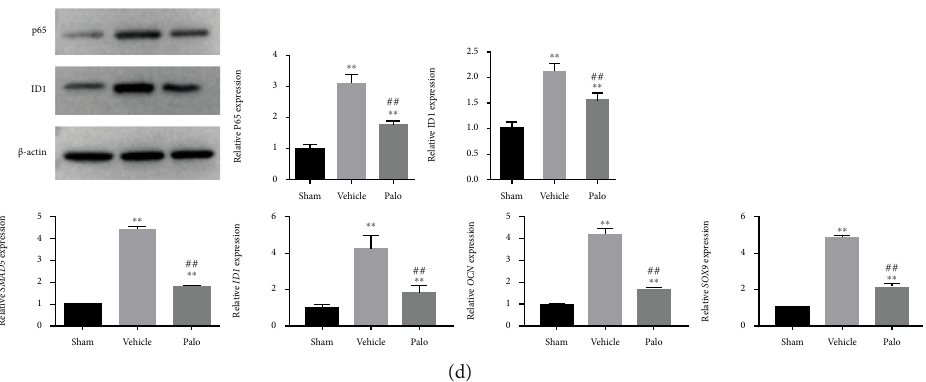
Figure 6: In vitro experimental further veri fi es the e ff ects of palovarotene and Smad and NF- κ B signaling pathways in HO. In immunohistochemistry, the positive rate of in fl ammation such as TNF- α , TGF- β , IFN- γ , IL-1 β , and MMP-9 was increased (a), as well as p65, ID1, p-SMAD1/5, and osteogenic genes, concluding OCN and SOX9 (b). Scale bar = 25 μ m. (c) Immuno fl uorescence and quantitative analysis against Smad5. Scale bar = 25 μ m. Data are means ± SD ( n = 3 ) ∗ p < 0 : 05 and ∗∗ p < 0 : 01 . # p < 0 : 05 and ## p < 0 : 01 . (d) The mRNA expression, Western blot analysis of tendon tissues, and relevant quantitative analysis of p65, ID1, OCN, and SOX9. Data are means ± SD ( n = 3 ). ∗ p < 0 : 05 and ∗∗ p < 0 : 01 . # p < 0 : 05 and ## p < 0 : 01